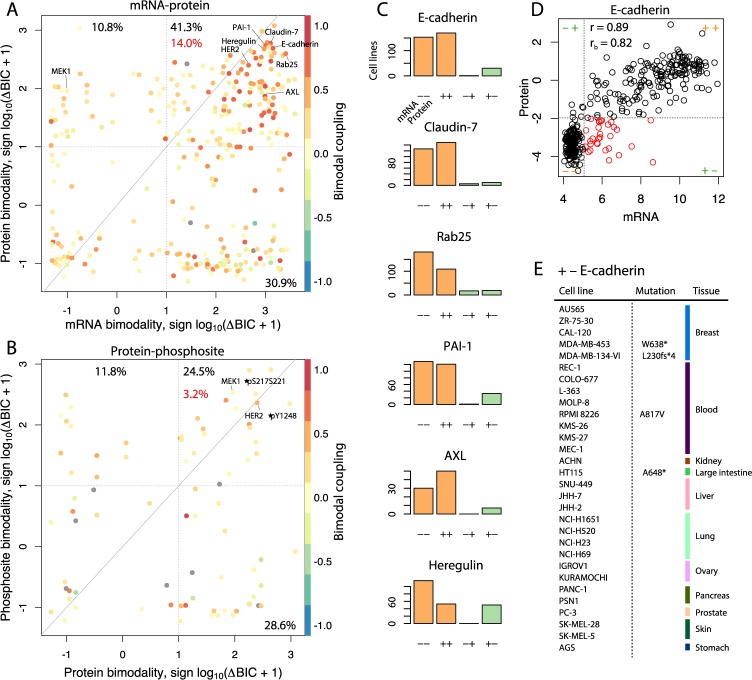
Bimodal coupling between regulatory layers.(A) Comparison of mRNA and protein bimodality colored by the coupling (Spearman’s correlation) between posterior probabilities of two-component Gaussian mixture models. The red percentage indicates the fraction of compared genes with coupled (rb > 0.5) bimodalities at the transcript- and protein level. (B) Bimodal coupling of phosphosites and protein expression. (C) High confidence assignments (p < 0.1) to low or high expression for selection of bimodally coupled mRNA-protein pairs. (D) Scatter plot of E-cadherin mRNA and protein expression, indicating in red the 30 cell lines assigned to high mRNA but low protein expression (+–). r is Pearson’s correlation and rb the bimodal coupling coefficient. (E) Tissue of origin and CDH1 (E-cadherin) mutational status of 30 cell lines with high E-cahderin mRNA but low protein expression. Of these cell lines, 3 out of 4 cell lines genotyped for CDH1 in COSMIC, all had mutations in the coding sequence. fs: frameshift, *: missense.